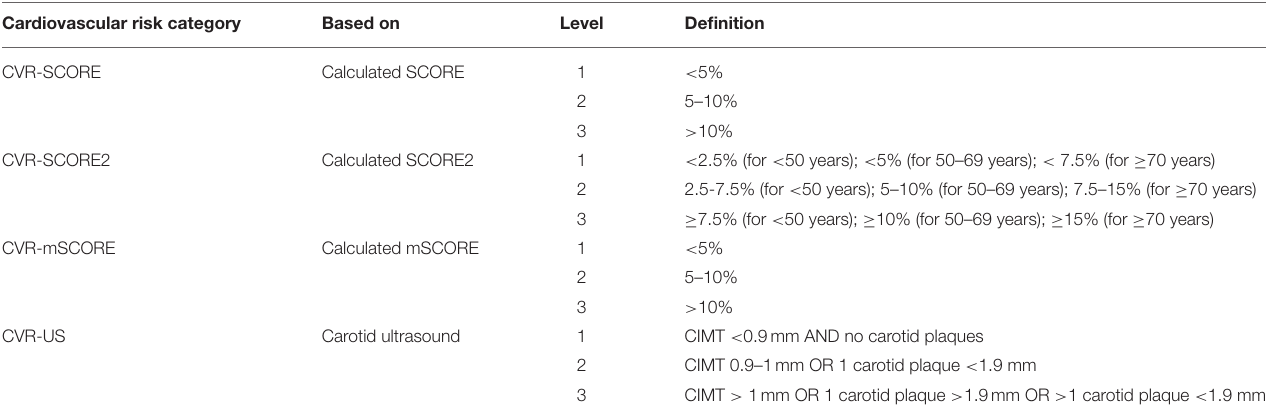
TABLE 4 | Definition of the cardiovascular risk categories and levels based on the CV risk score (SCORE, SCORE2, mSCORE) and carotid ultrasound examination (CIMT, and plaque detection). Cardiovascular risk category